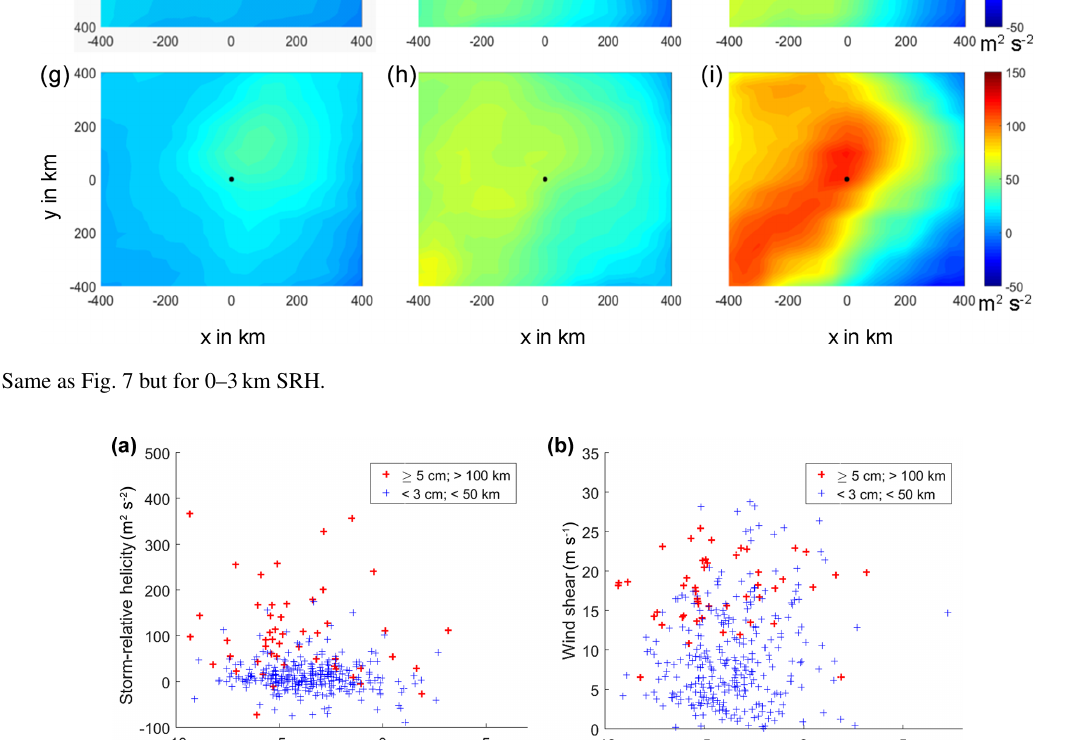
Figure 10. Scatterplots between (a) SLI and SRH and (b) DLS for two different categories of track length and hail diameter.